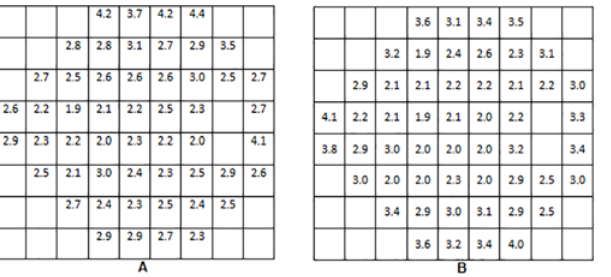
Fig 4. Retinal sensitivity standard deviations at each location in normal group for Compass (A) and HFA